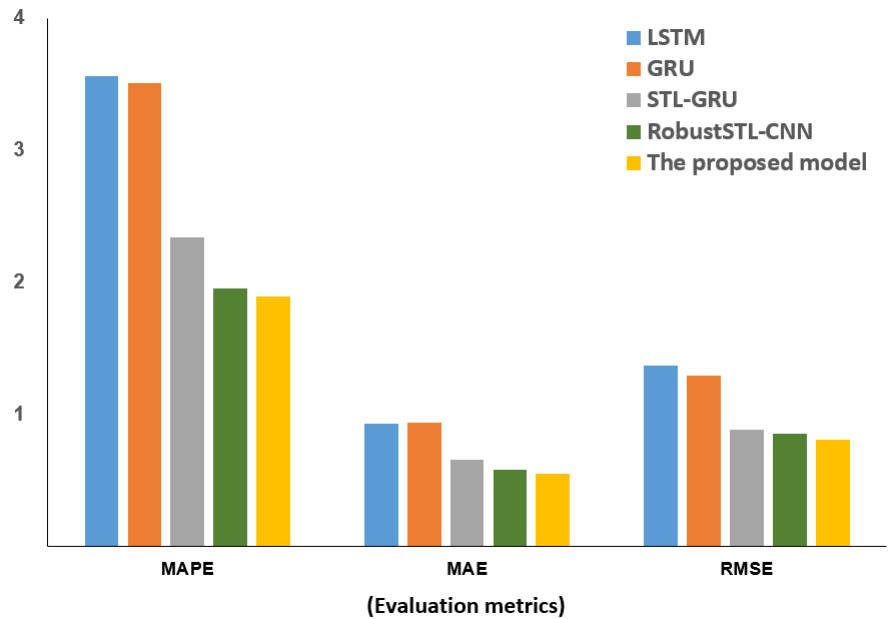
Figure 6. Evaluation results of the proposed model and counterpart